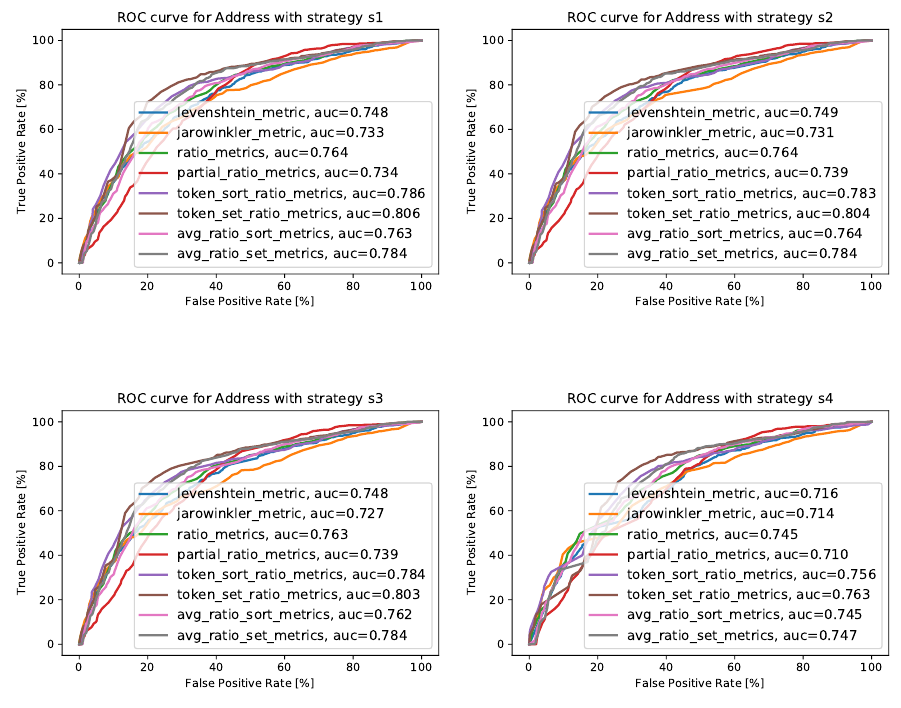
Figure A2. A receiver operating characteristics for all considered string similarity metrics for all four strategies for dealing with missing data for attribute Address